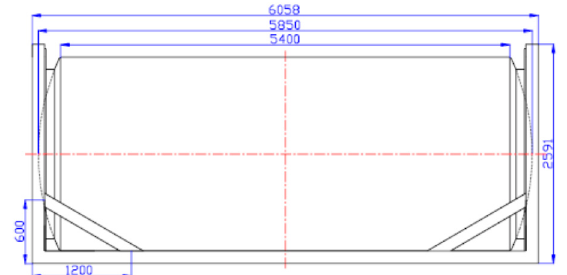
Figure 3. Side view.